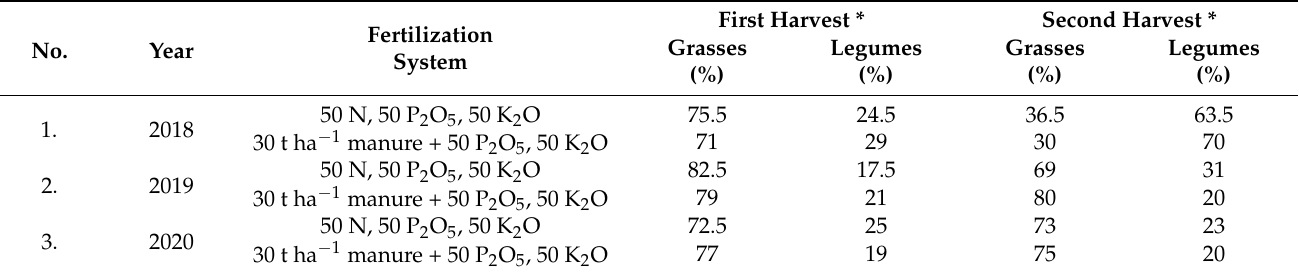
Table 5. The floristic structure of the production of the temporary grassland in years 2018, 2019, 2020